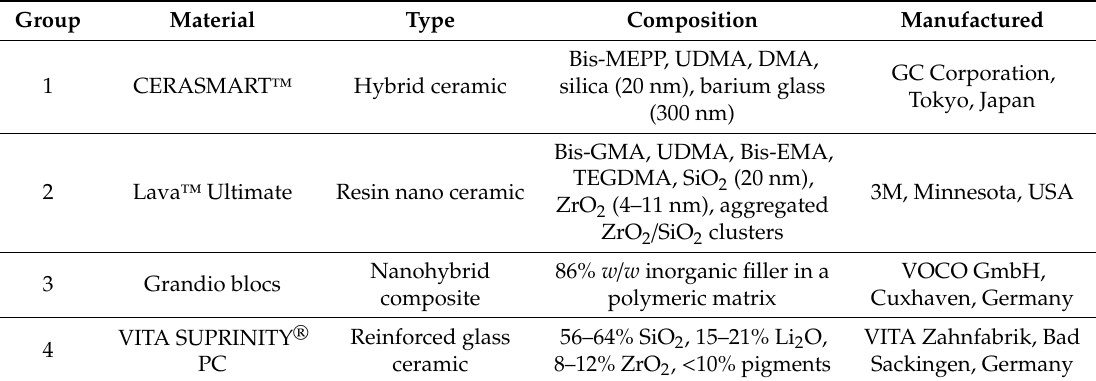
Table 1. Characteristics of the materials used in the